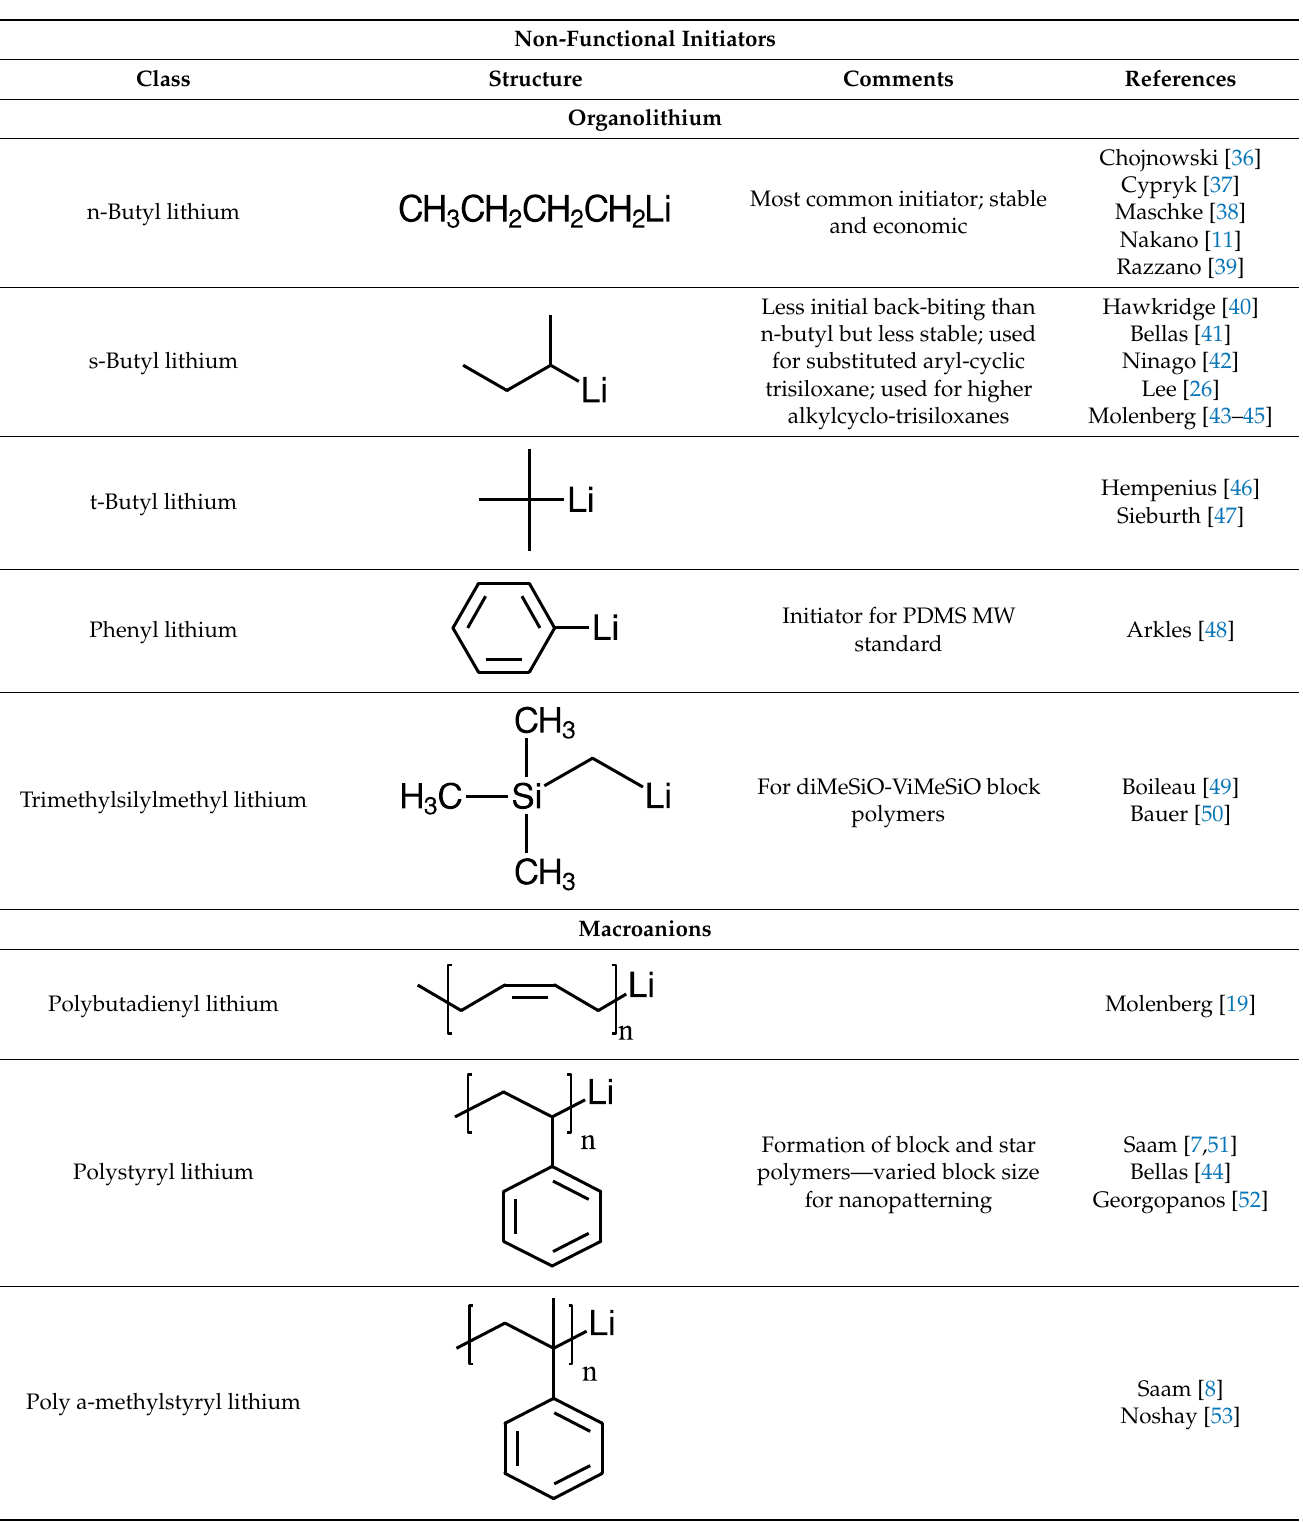
Table 2. Table 2. Initiators. Table 2. Initiators. Table 2. Initiators. Table 2. Initiators. Table 2. Initiators. Table 2. Initiators. Table 2. Initiators. Table 2. Initiators.